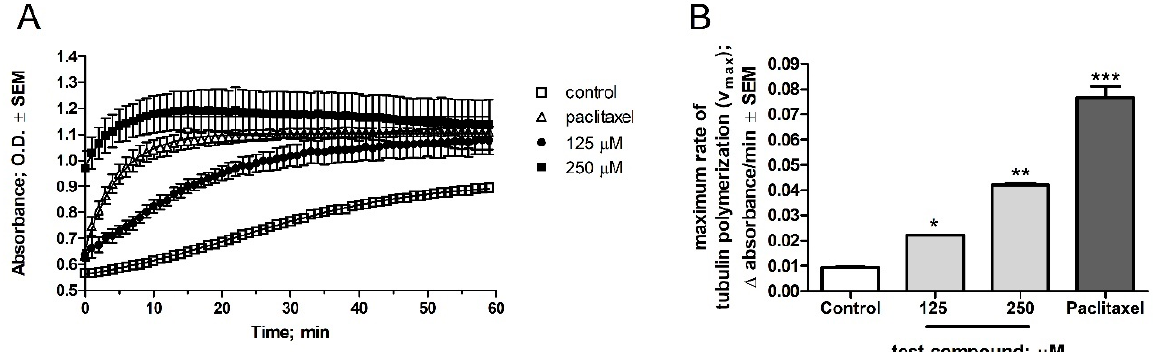
Figure 5. Effects of 14i and 10 μ M paclitaxel on the calculated maximum reaction rate (Vmax) of in vitro microtubule formation. ( A ) Representative kinetic curves; ( B ) Calculated results. Control: untreated samples. The experiment was performed in two parallels and the measurements were repeated twice. Each bar denotes the mean ± SEM; *, ** and *** indicate p < 0.05, p < 0.01 and p < 0.001, respectively, compared with the control values.